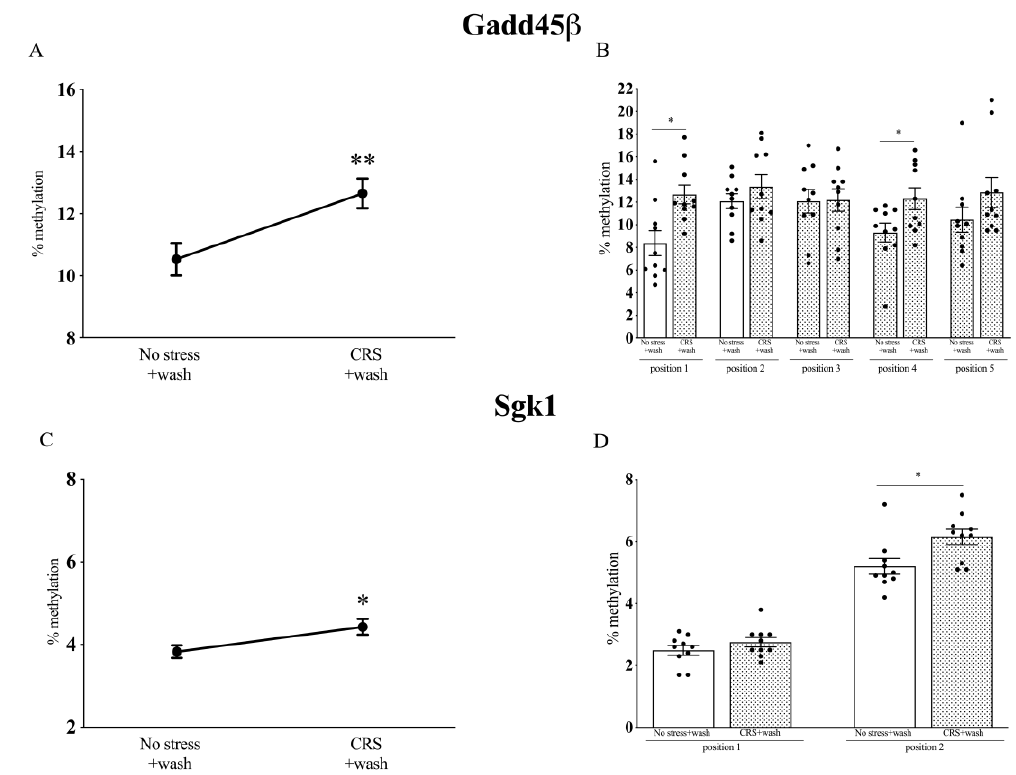
Figure 4. Analysis of Gadd45 β ( A , B ) and Sgk1 ( C , D ) DNA methylation in the prefrontal cortex of chronically stressed rats (CRS) after 3 weeks of washout. The data, expressed as methylation percentage, are the mean ± SEM of the positions analyzed. * p < 0.05, ** p < 0.01 vs. No stress (Unpaired t -test).